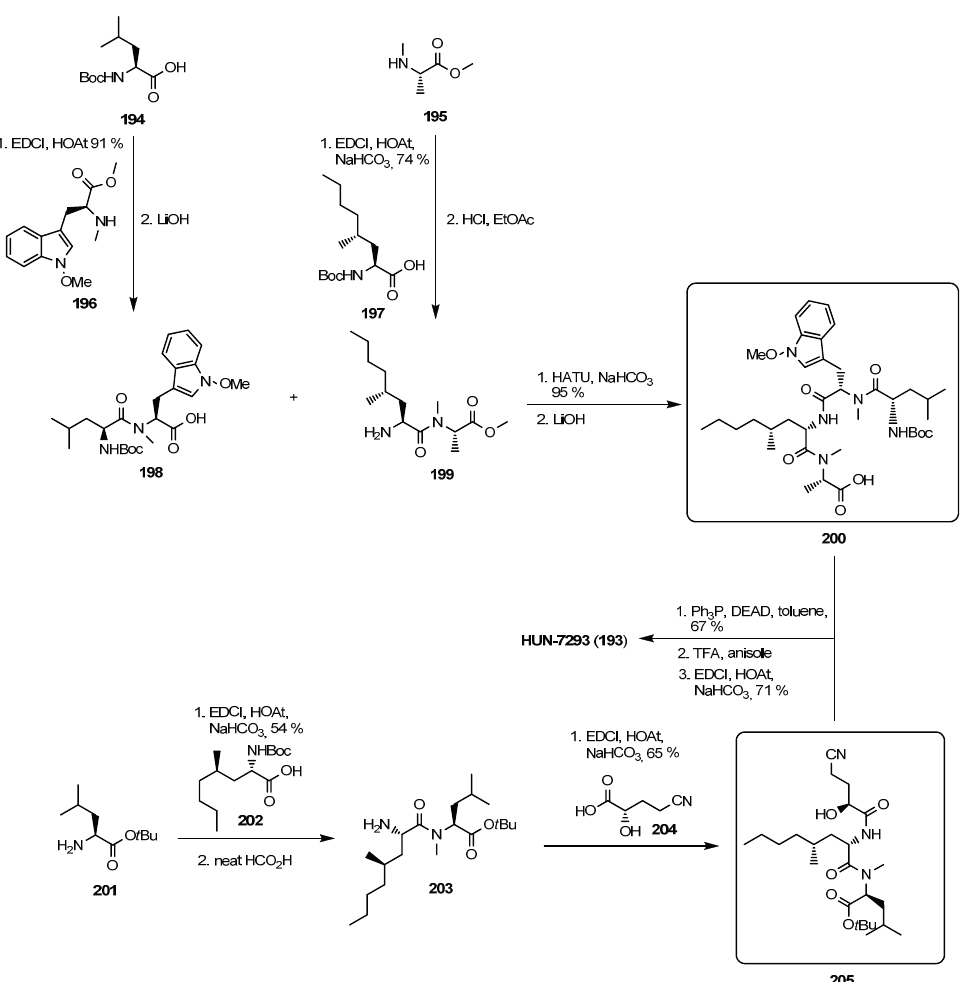
Scheme 11. Synthesis of HUN-7293 ( 193